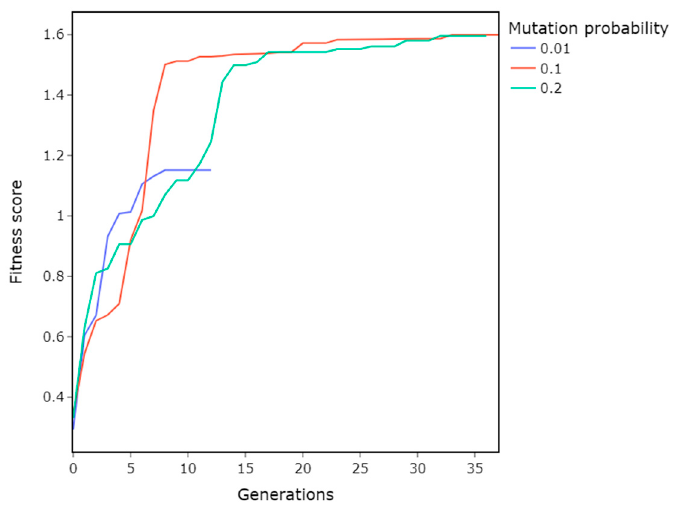
Figure 6. Impact of mutation probability on the GA’s performance. The mutation probability of 0.1 shows the best performance. A higher probability of 0.2 does not perform better and a lower probability of 0.01 underperforms.